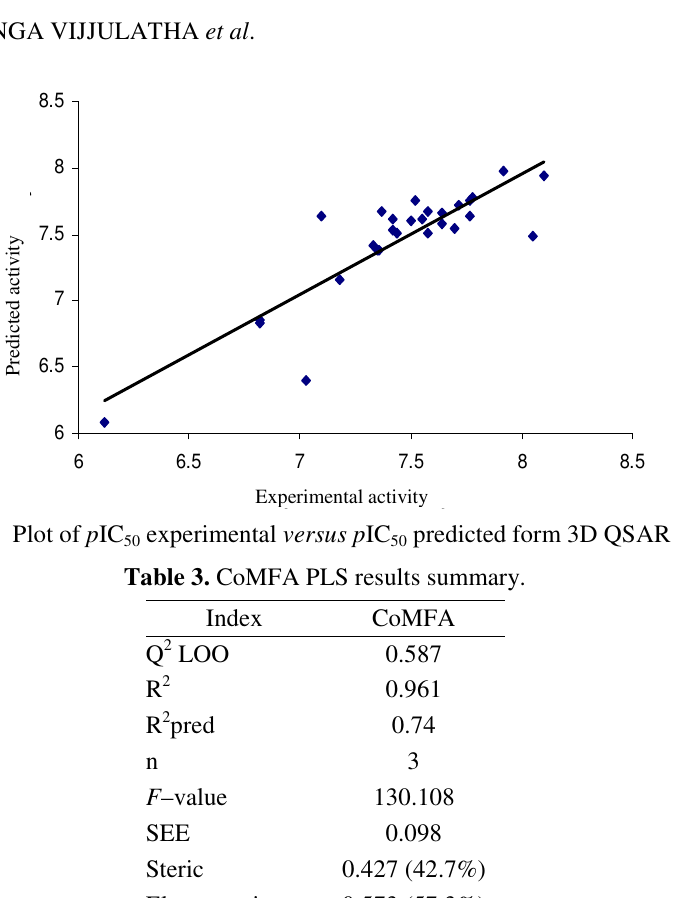
predicted form 3D QSAR model. 50